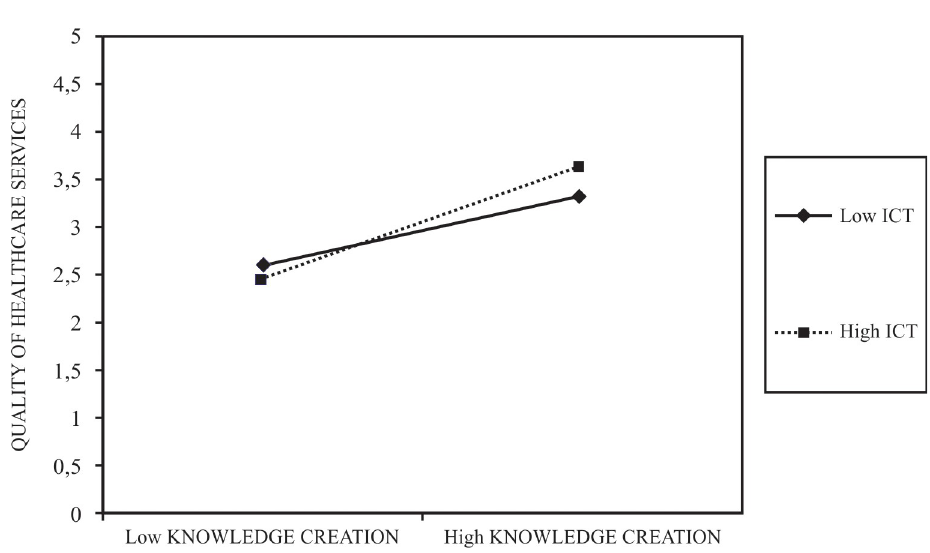
Fig 2. Interaction between knowledge creation and information communication technologies in influencing quality of healthcare services.